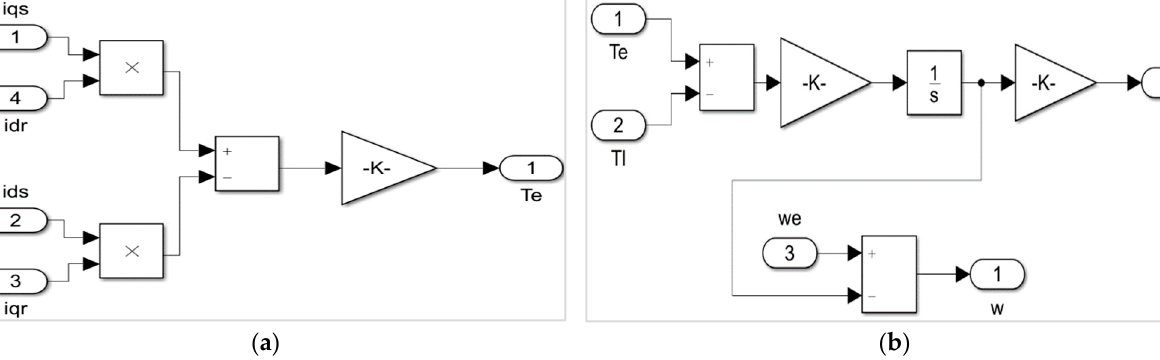
Figure 9. ( a ) Torque equation; ( b ) speed equation.